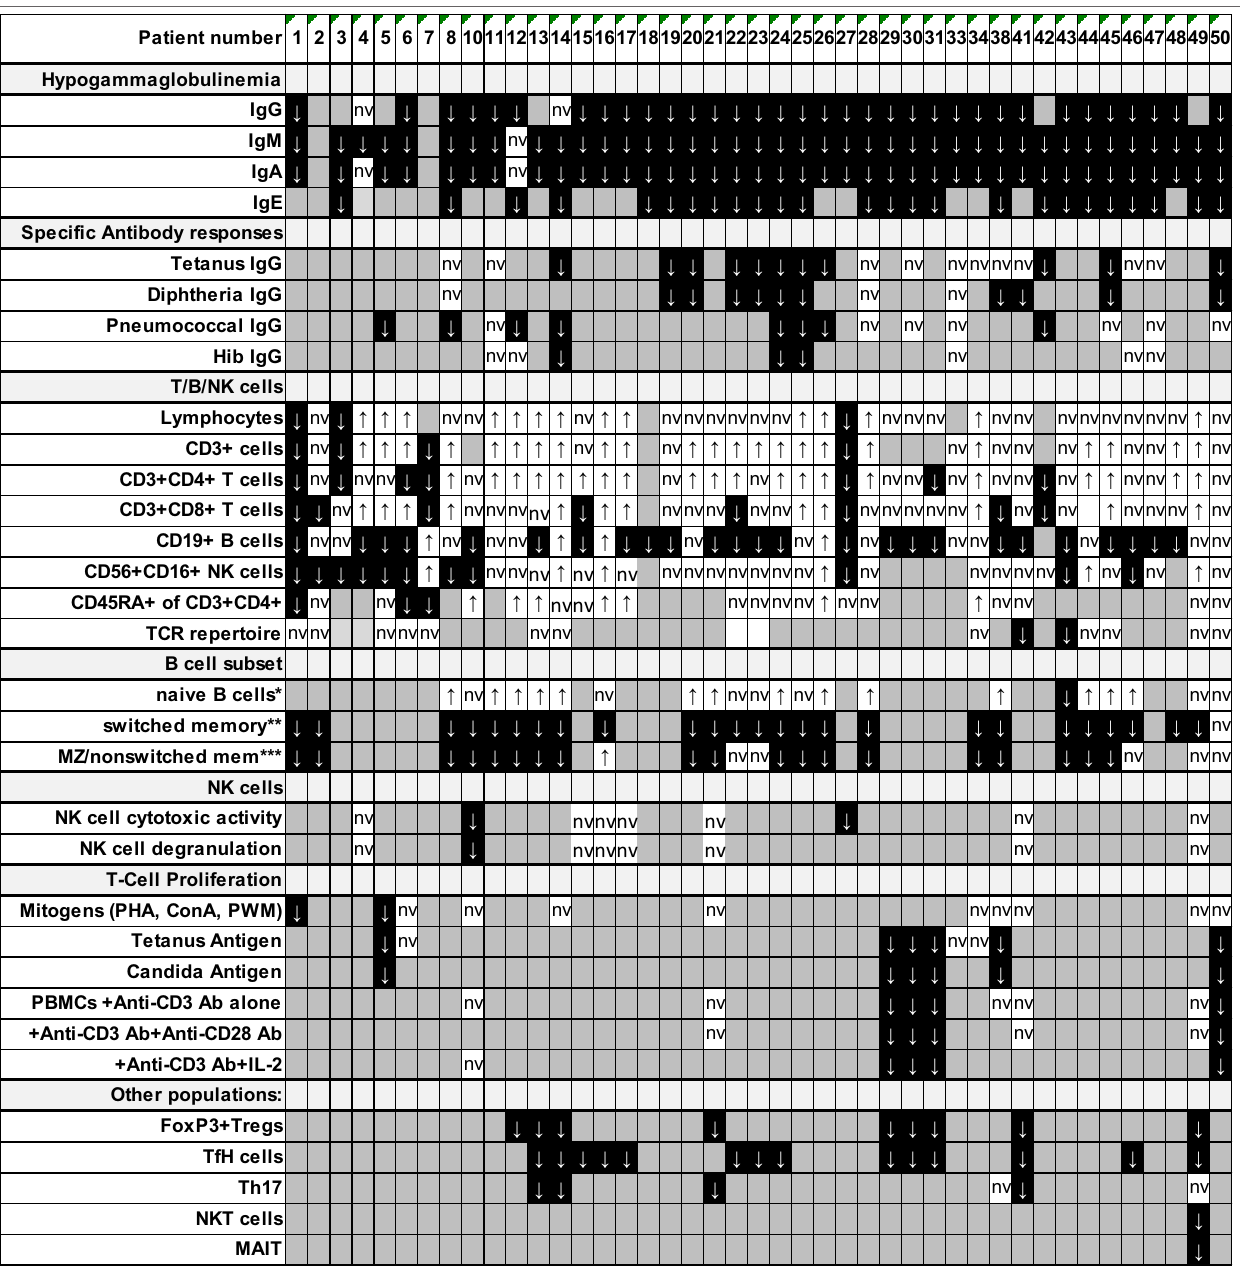
TABLE 5 | Immunological phenotype in patients with NFKB2